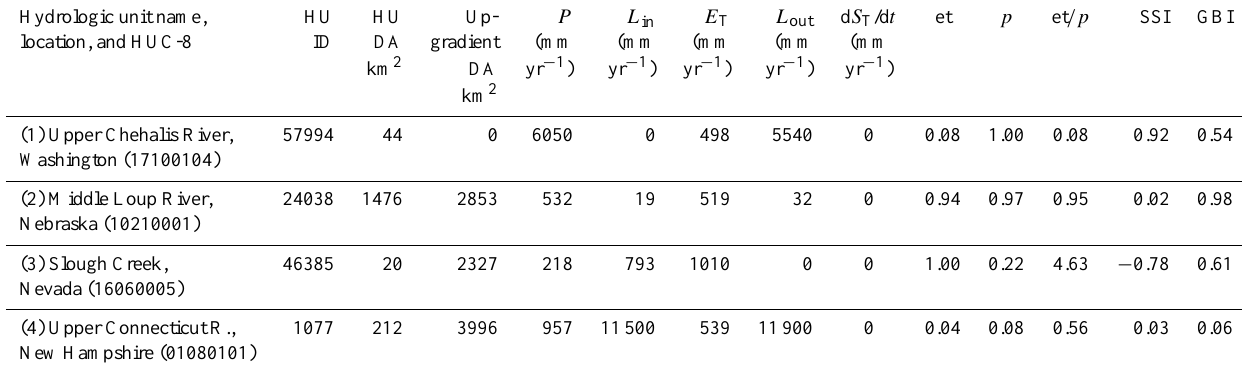
Table 1. Water-balance components and hydroclimatic regime indicators; sites 1, 2, 3, and 4 (Fig. 1e). The regime of each site approaches one of four end members shown in Fig. 1c. See Table 2 for indicator definitions. Mean-annual (1896–2006) water-balance components obtained from the distributed water-balance model of the conterminous USA (see Sect. 3). HUC-8 (eight-digit hydrologic-unit code; see Supplement); HU ID, hydrologic-unit identifier, water-balance model; DA, drainage area. P , precipitation; E T , evapotranspiration; L in , landscape